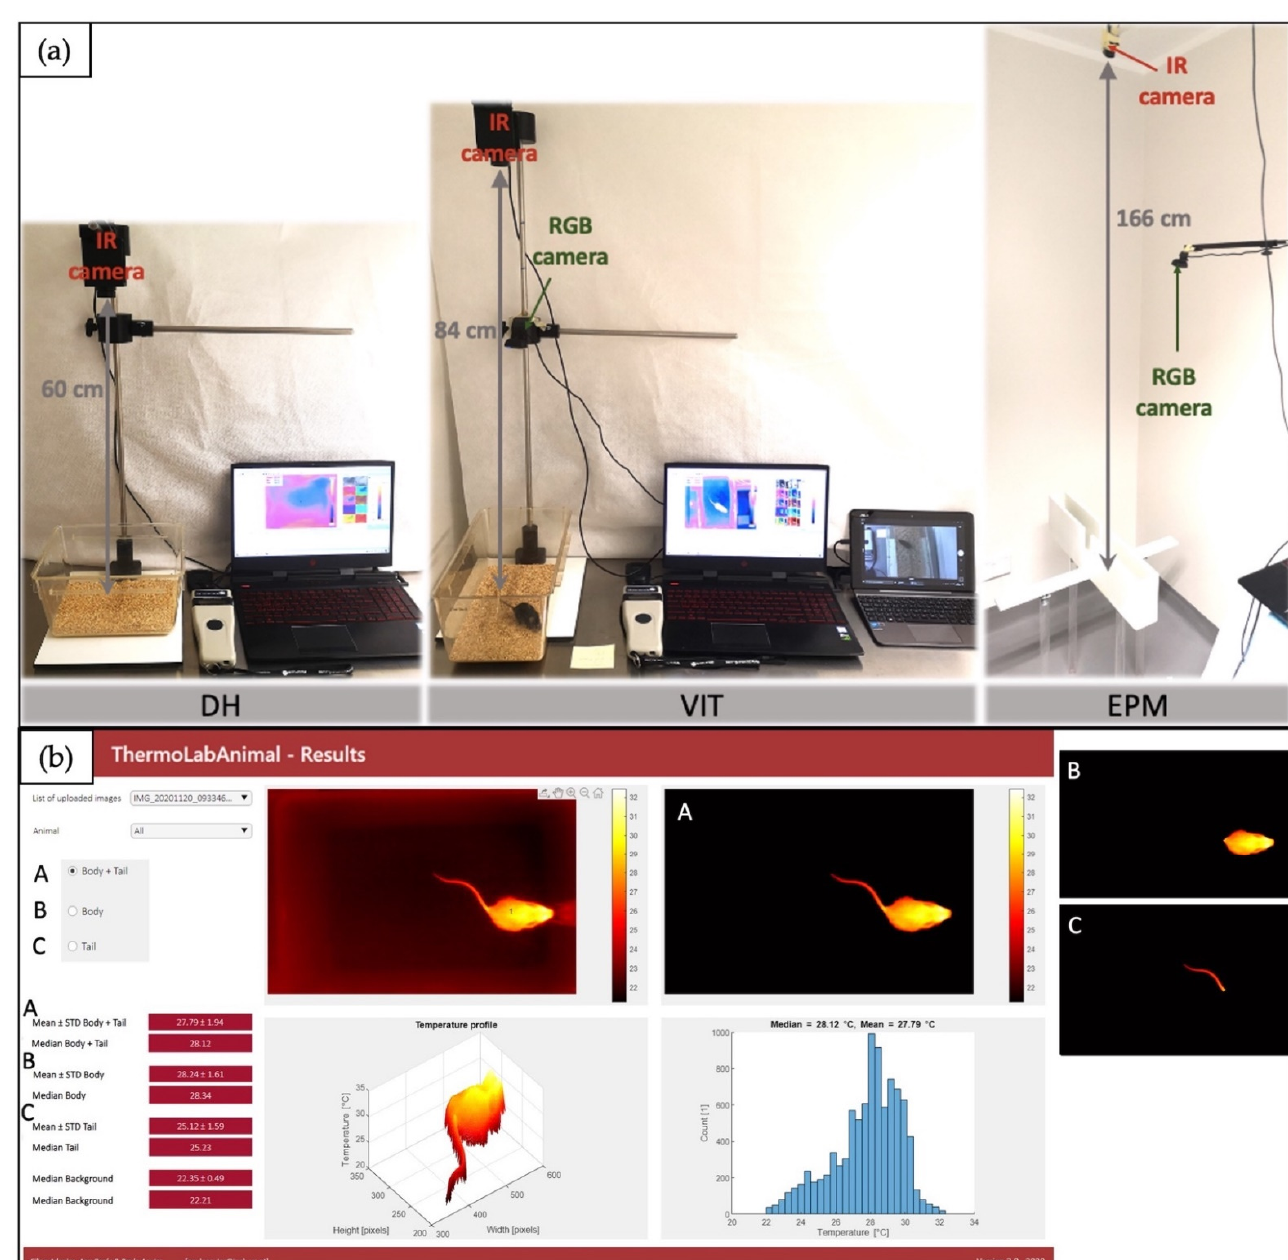
Figure 2. ( a ) Illustration of an experimental setting for Daily Handling (DH), Voluntary Interaction Test (VIT) and Elevated Plus Maze (EPM) and ( b ) output result from ThermoLabAnimal 2.0 software, using U-Net-based method, showing input image (upper left image), region recognized as animal (upper right image), with the possibility to separately analyze body and tail ( A ), only body ( B ) and only tail ( C ), with mean and median calculations provided for each region of interest.